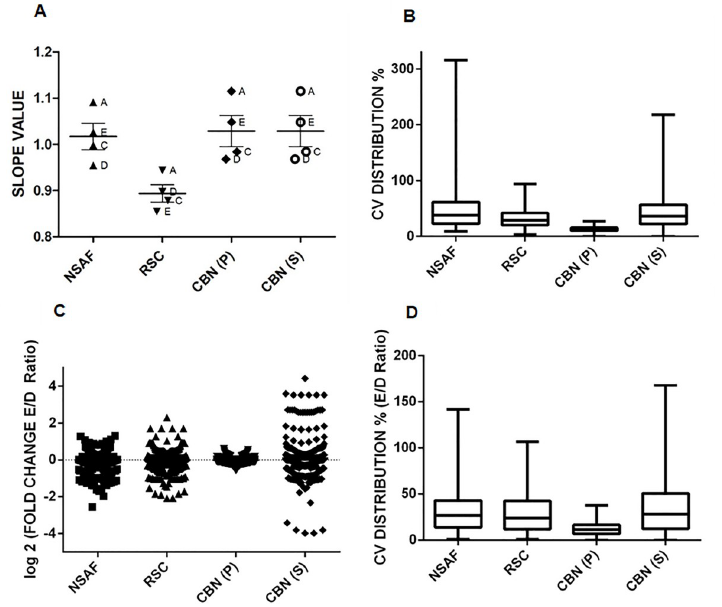
Fig 2. Comparative analysis of all spectral counts normalization methods applied to E . Coli proteome. (A) Median values for the best fitting slopes calculated for each pair of technical replicates for all samples analyzed (except mixture B) with each normalization method. (B) Coefficient of variation (CV) for the evaluation of data dispersion for all the normalization methods used in the analysis of E . Coli proteome. (C) Representation of the logarithmic Fold Change distribution around the theoretical value indicated by the point line for all normalization methods. (D) Box plots of the CV for the fold change in the mix E / mix D pair, calculated on all the four possible pairs of the technical replicates. In panels B and D the box and whisker extremes represent